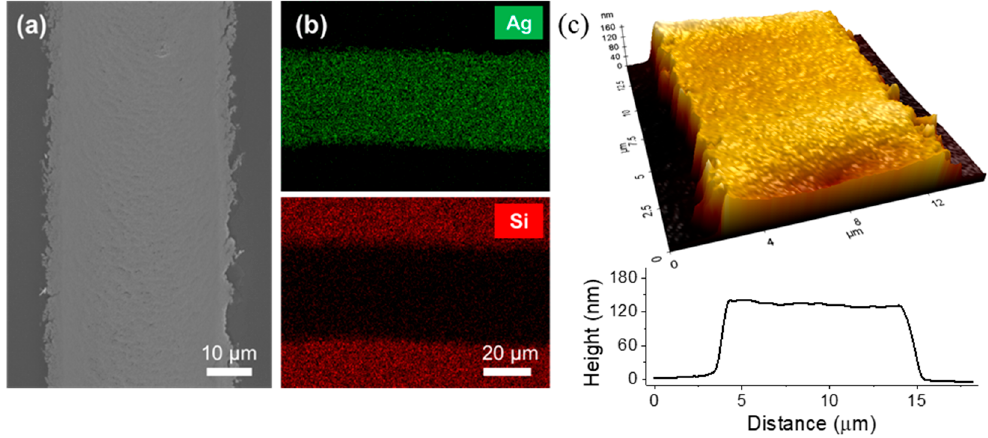
Figure 5. ( a ) SEM, ( b ) EDX and ( c ) AFM measurement of the laser-transferred Ag NP layer on PDMS